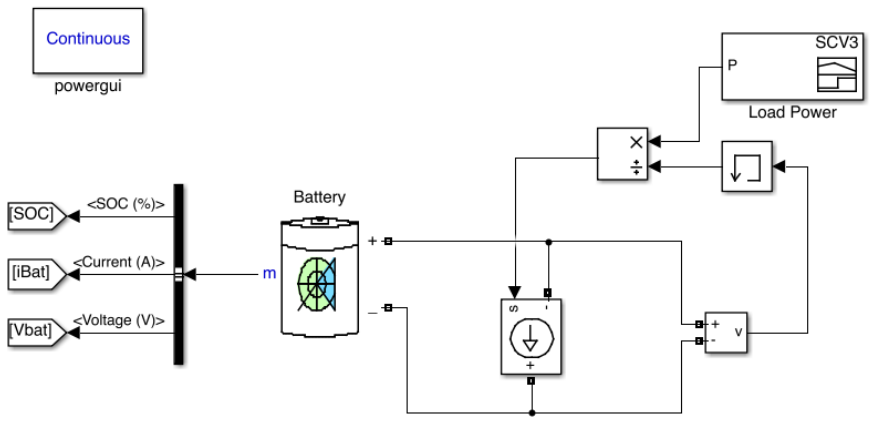
Figure 8. Battery-only powertrain simulation